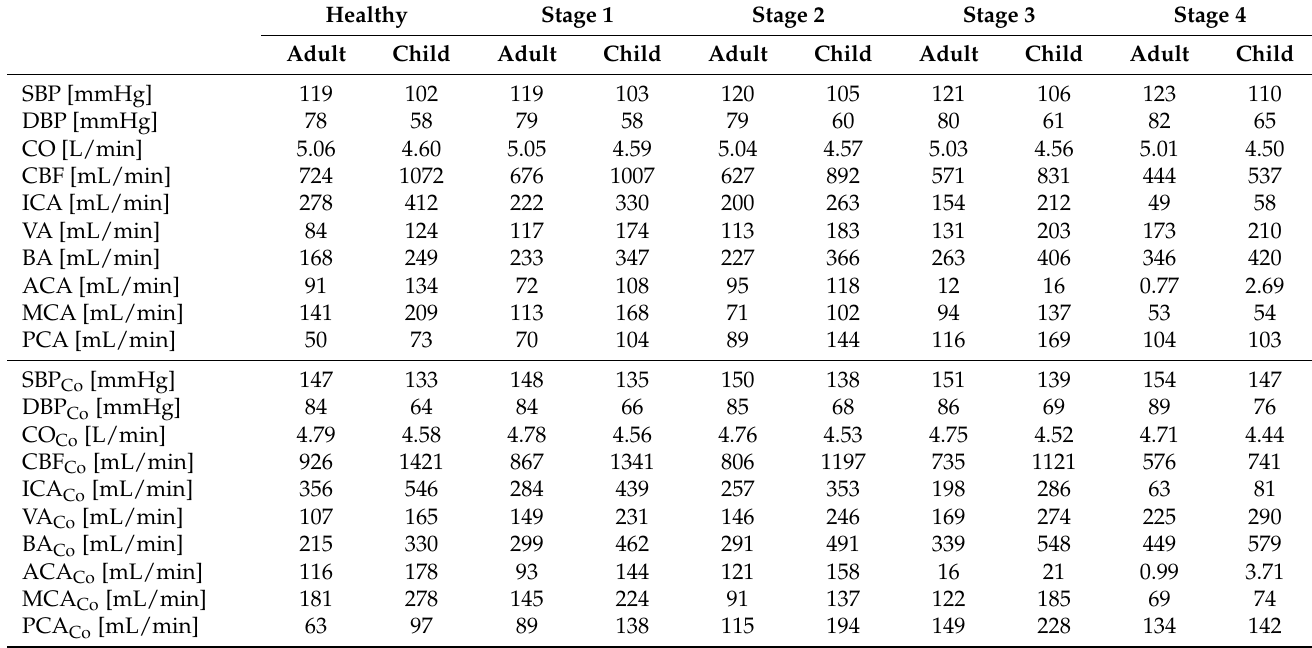
Table 1. Systolic and diastolic aortic blood pressures (SBP and DBP), cardiac output (CO), total cerebral blood flow rate (CBF), and mean cerebral blood flow rates in the internal carotid, vertebral, basilar, anterior, middle, and posterior arteries (ICA, VA, BA, ACA, MCA, and PCA) in the adult and child cardiovascular system models simulating healthy conditions and advancing stages of the Moyamoya disease with and without coarctation of the